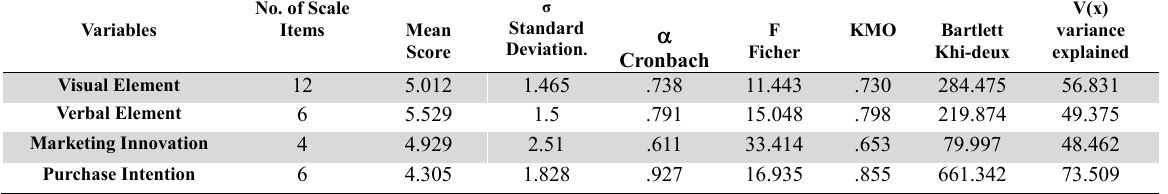
Descriptive statistics reliability measures and Factor Analysis ( N =